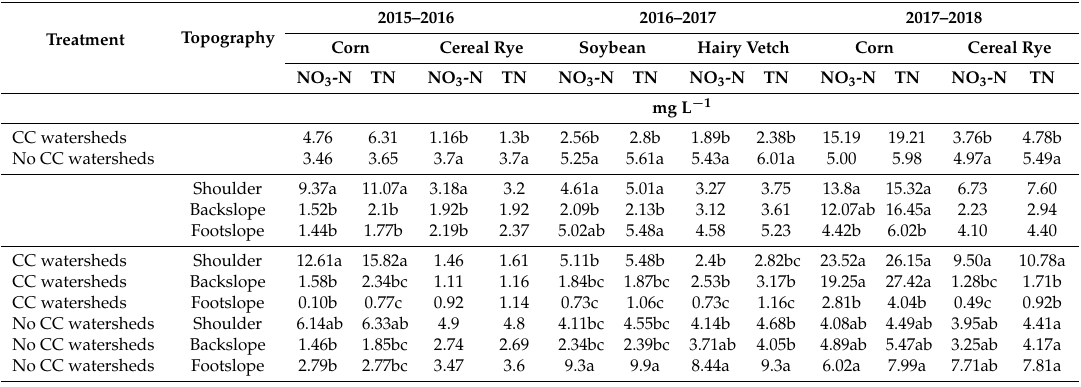
Table 7. Comparison of mean nitrate-N (NO 3 -N) and total N (TN) concentrations collected using tension cup lysimeters. Within a column and within a given factor or combination of factors, means followed by the same letter are not statistically different ( α =